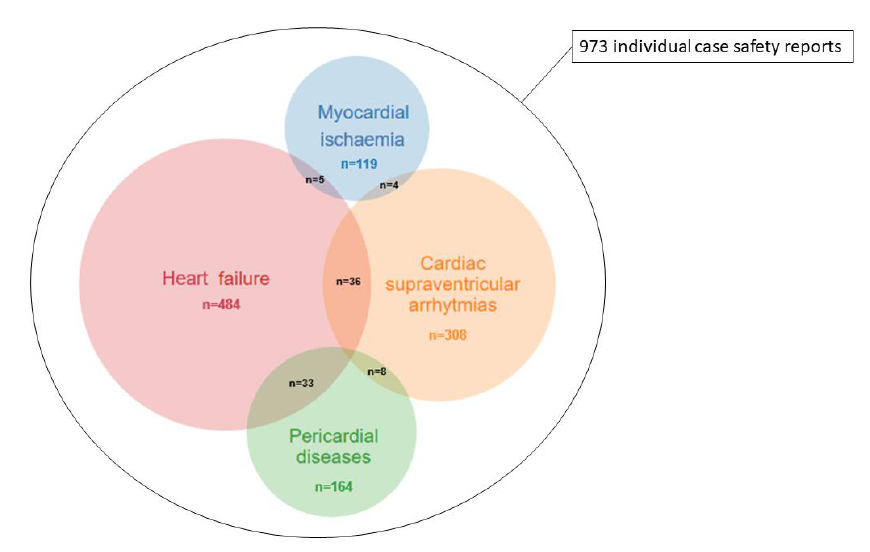
Figure 1. Individual case safety reports and overlap for gemcitabine-associated cardiovascular adverse drug reactions (CV-ADRs) in VigiBase (accessed on 1 April